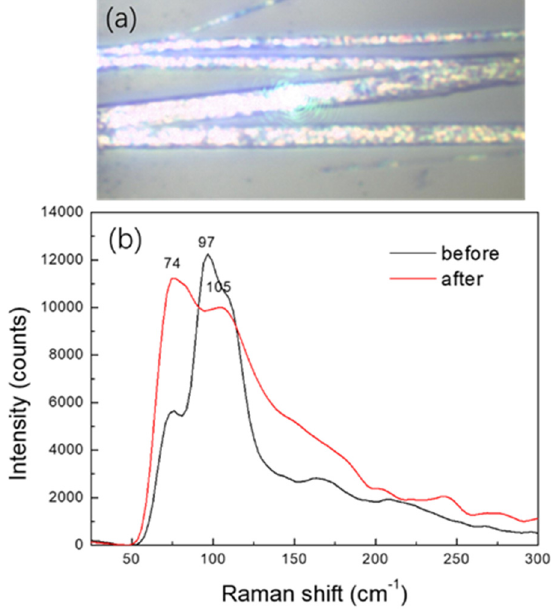
Figure 4. ( a ) The OM image of a laser-induced annealing point on a perovskite MW; ( b ) the typical Raman spectra before and after the laser annealing. Here, the violet laser power was kept as 17 mW, and the exposure time was 5 s.